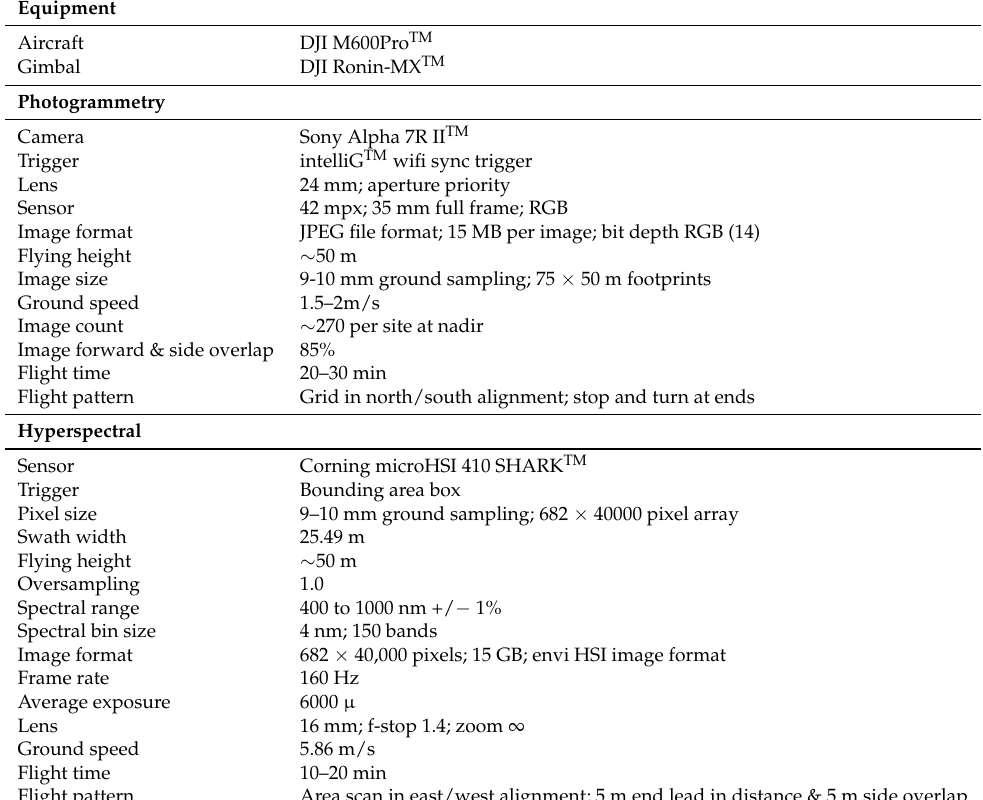
Table 2. UAV flight mission